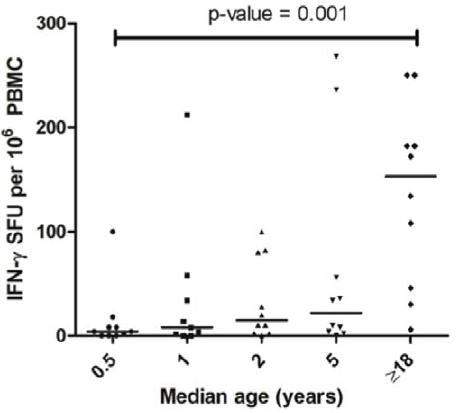
Figure 1. Magnitude of peripheral blood mononuclear cell IFN- c responses to 3D7 MSP1 42 according to age. The magnitude of response was measured by counting the spot forming units (SFU) for PBMCs stimulated with MSP1 42 after subtracting SFU for PBMCs incubated with culture medium/PBS (background range 0–50 SFUs/ 10 6 PBMCs). There was an age-related increase in the